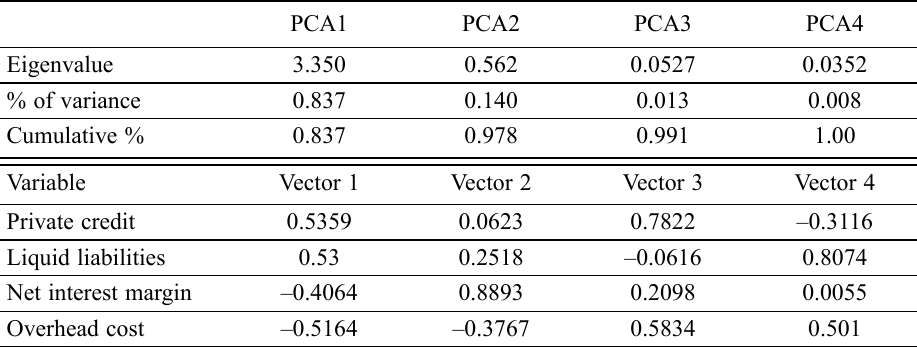
Table 3. Principal component analysis for banking sector development